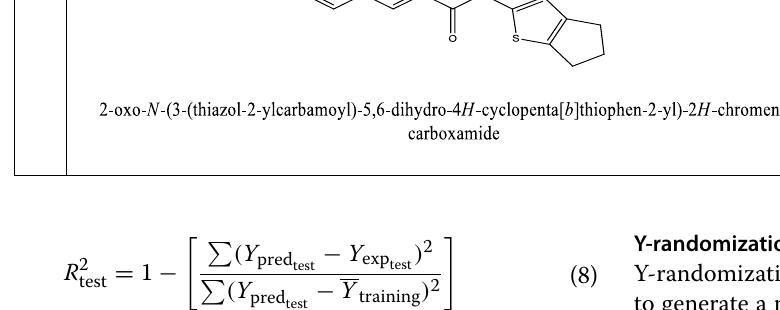
Y‑randomization Y-randomization is an external validation test performed to generate a new model from the bogus dataset so as to improve the models’ efficacy. For a good model, the ran- domized squared correlation coefficient ( cR greater than 0.5, and is expressed